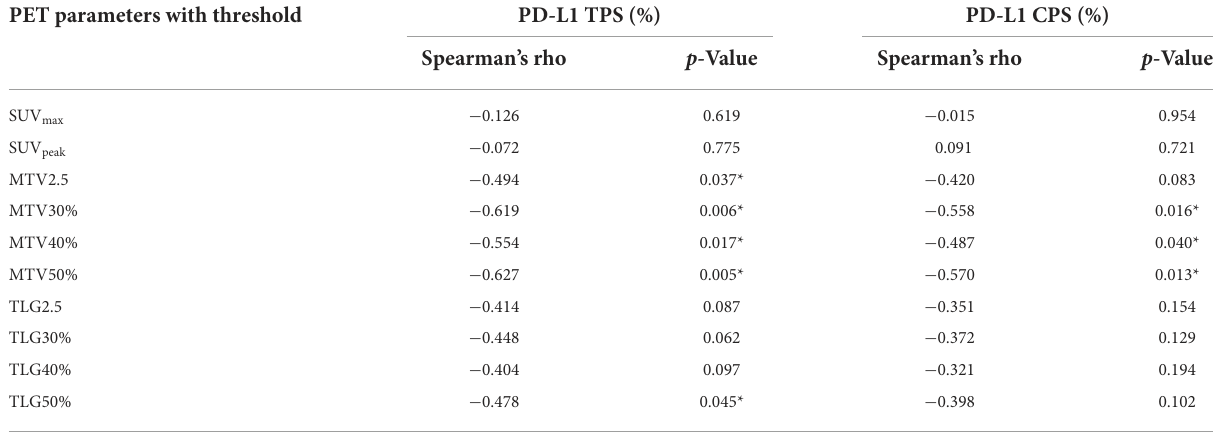
TABLE 5 Correlation between PD-L1 expression and PET parameters. PET parameters with